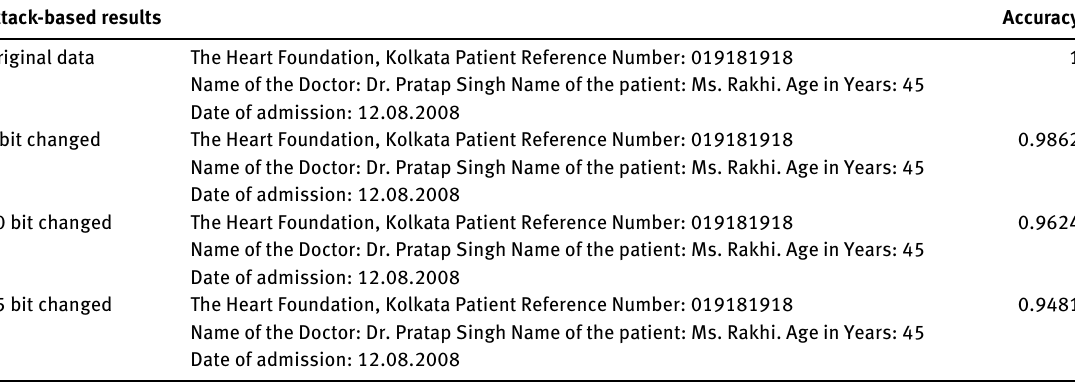
Table 9: Attack-Based EHR